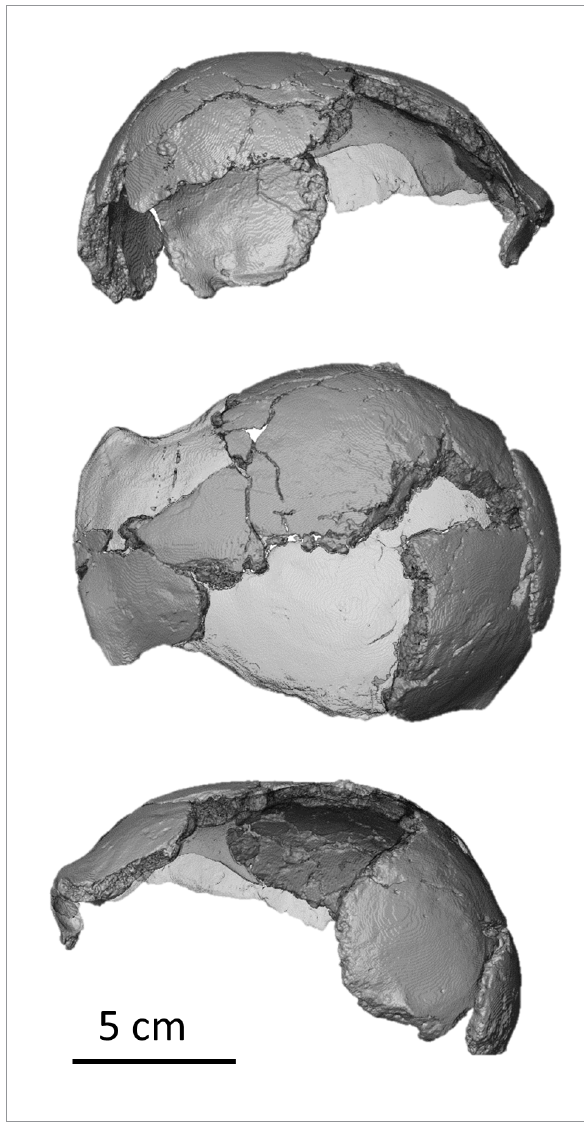
Figure 1: Virtual rendering of the StW 578 calotte in lateral right (top), superior (middle) and lateral left (bottom) views. Plaster used to physically reconstruct the cranium is in light grey and